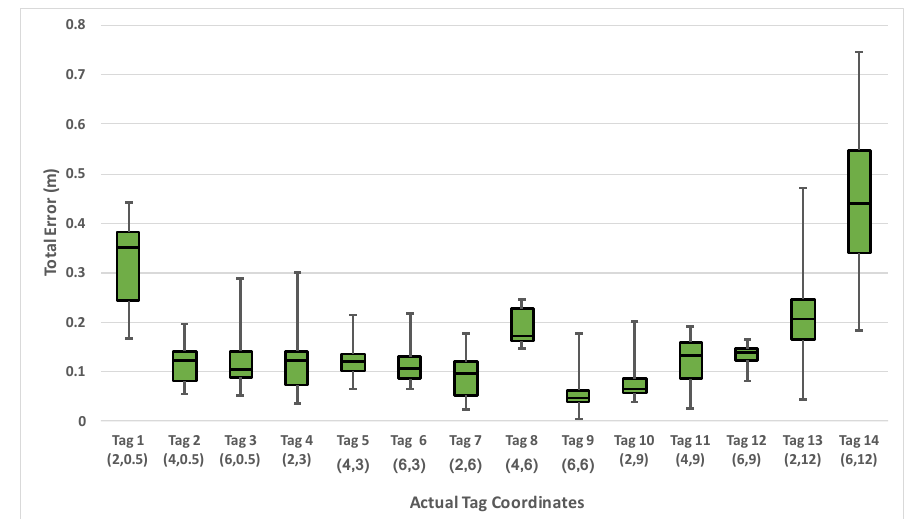
Figure 8. The location error at each potition.